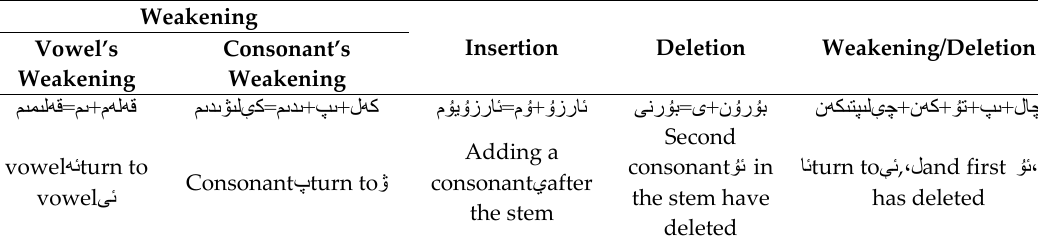
Table 7. Uyghur morphological changing phenomenon.